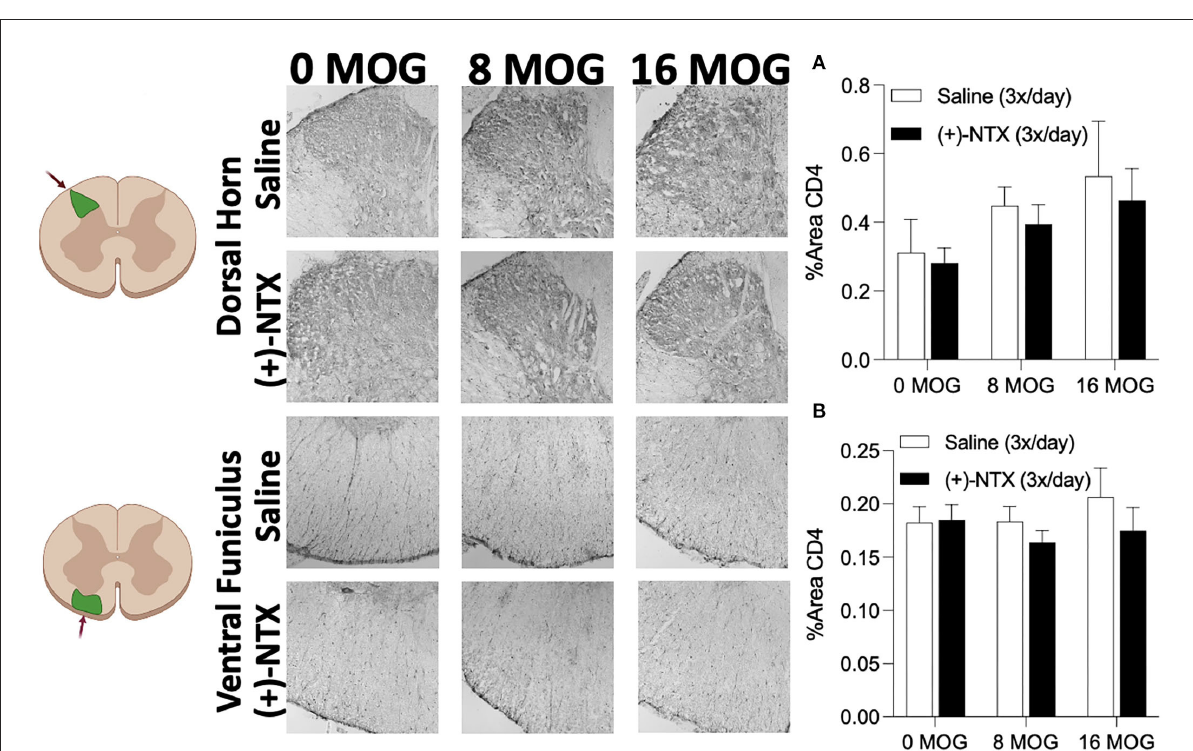
FIGURE9 Myelin oligodendrocyte glycoprotein (MOG) does not induce lumbar spinal cord dorsal horn or ventral funiculus CD4 immunoreactivity. Sprague-Dawley (SD) from Experiment 2 received intradermal low-dose (0, 8, and 16 µ g) myelin oligodendrocyte glycoprotein (MOG). Spinal cord tissue was collected on day 30 post-MOG administration and during 13 days of daily ( + )-NTX administration. Neither dose of MOG increased expression of the T cell immunoreactivity marker CD4 in either dorsal horn (A) or ventral funiculus (B) of lumbar spinal cord. ( + )-NTX administration also did not alter CD4 immunoreactivity in either region. N = 5–8/group with 2–4 pictures analyzed per